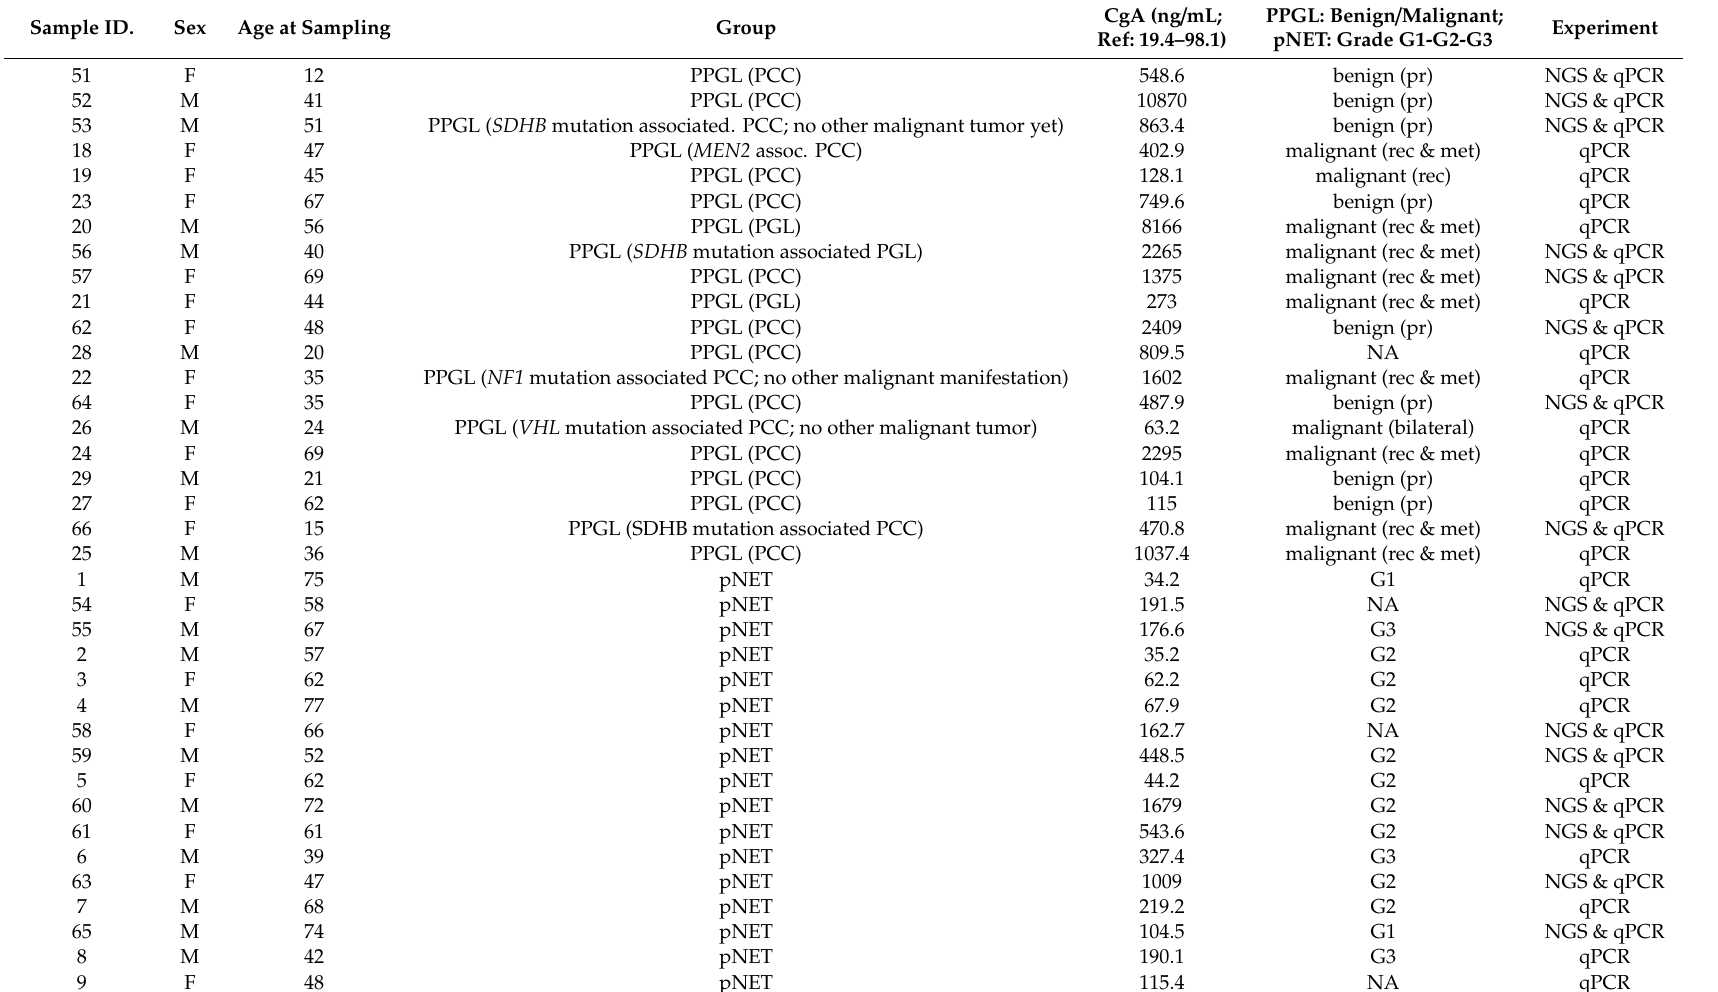
Table 5. Patient characteristics. The following paired samples are from the same healthy control with and without PPI treatment: 45 + 46; 47 + 48; 67 + 68; 33 + 49; 69 + 70. Sample